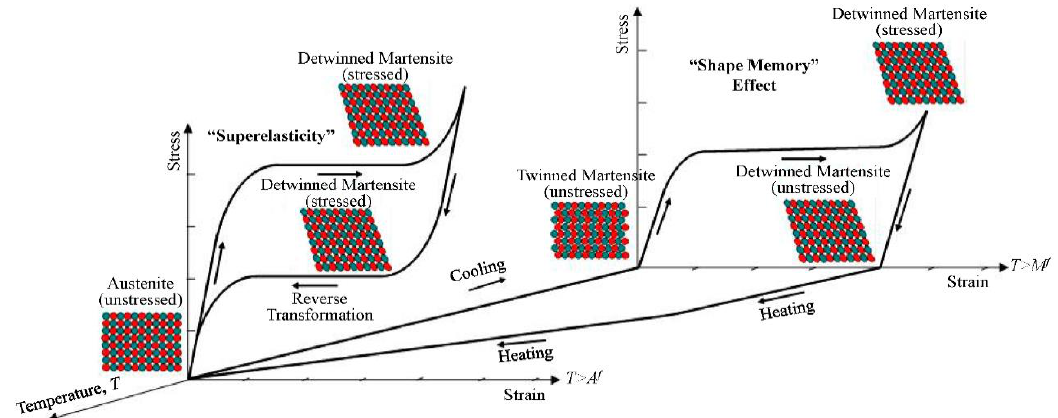
Figure 16. Stress–strain–temperature diagram of SMAs, illustrating both the shape memory and Figure 16. Stress – strain – temperature diagram of SMAs, illustrating both the shape memory and superelasticity phenomena [203]. Reprinted with permission from MDPI superelasticity phenomena [203]. Reprinted with permission from MDPI AG.